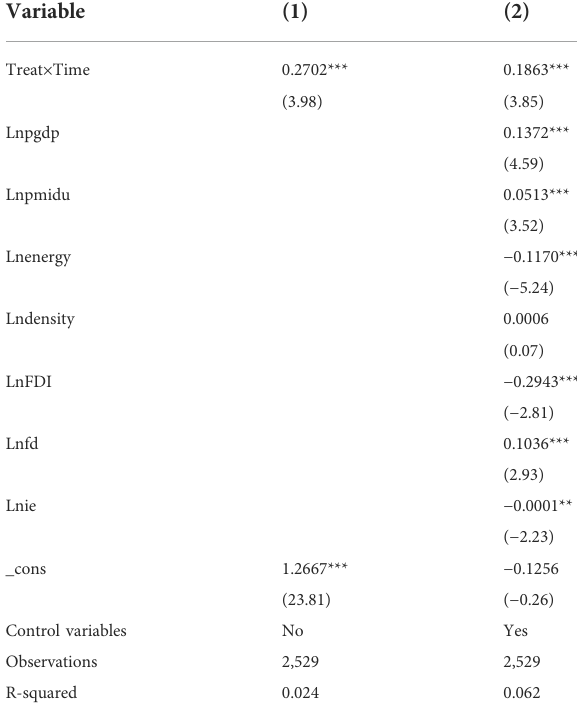
TABLE 3 DID baseline regression results (PCSE). TABLE4Innovatingthetransmissionmechanismofthecompensation effect